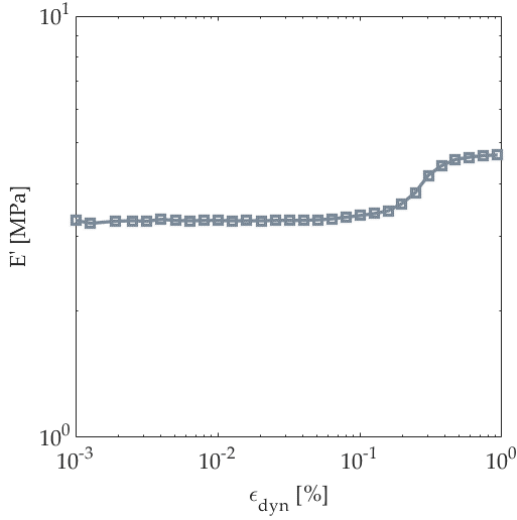
Figure 14 . Strain sweeps at constant frequency for composite door panels.